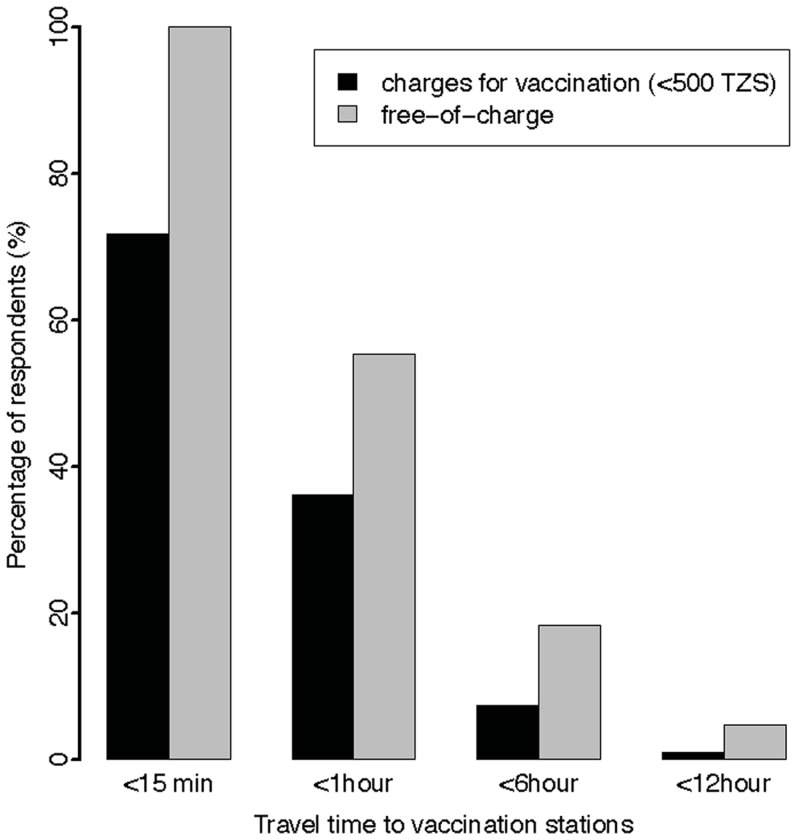
Comparison of reported willingness of respondents' to travel to central point dog rabies vaccination stations when vaccination is offered free of charge or at a cost.